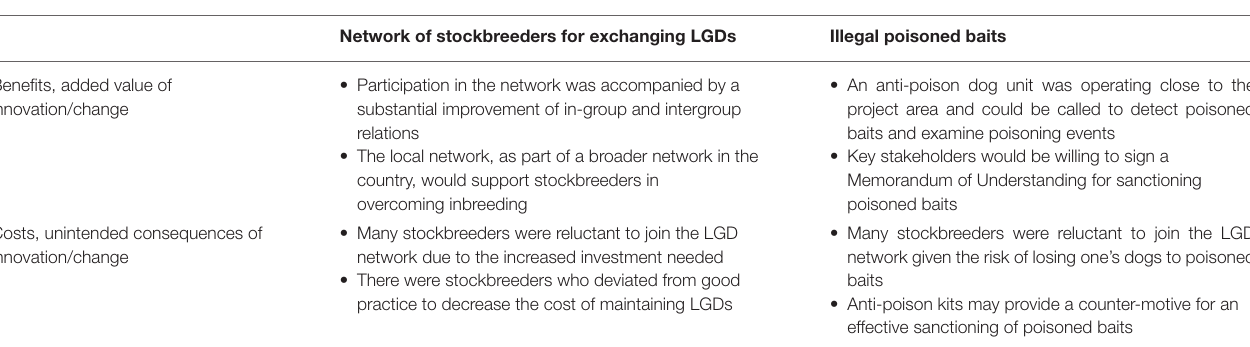
TABLE 8 | Mixed-motive template for